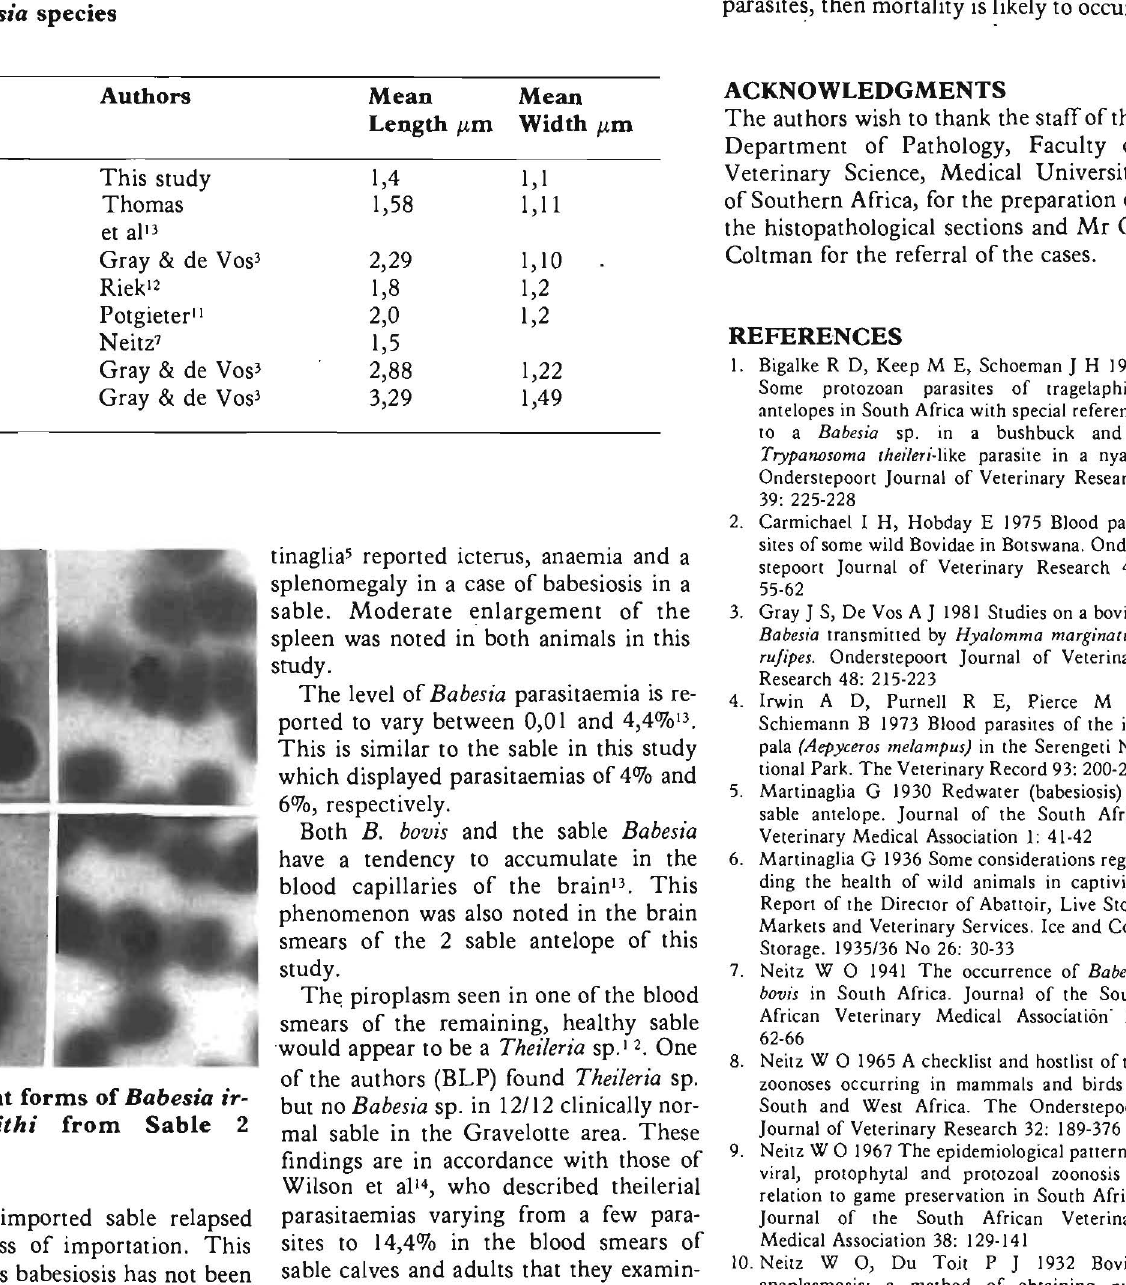
Table I: A comparison of the sizes of the sable Babesia and the bovine Babesia species